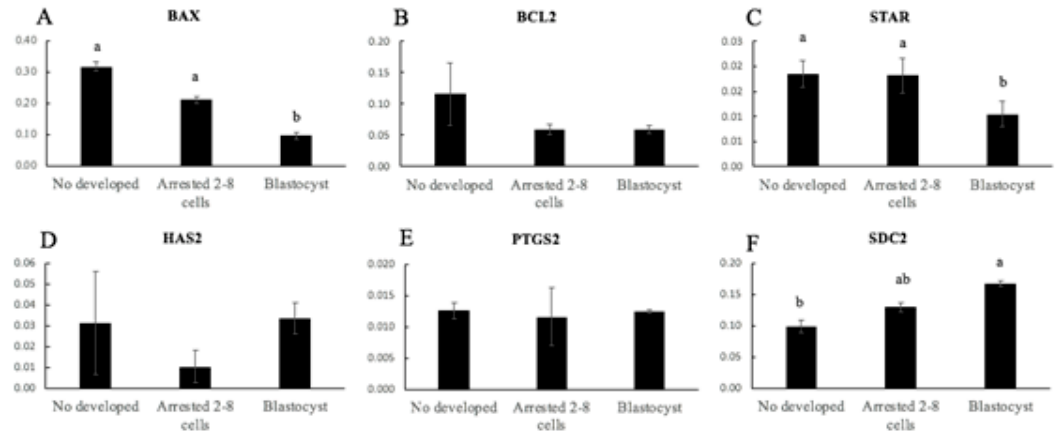
Figure 4. Relative gene expression of mRNA of BAX ( A ), BCL2 ( B ), STAR ( C ), HAS2 ( D ), PTGS2 ( E ), and SDC2 ( F ) and of cumulus cells from sheep oocytes according to the developmental stage reached (undeveloped, embryos arrested at the 2–8-cells stage, and blastocysts). Different letters denote significant differences ( p < 0.05, at